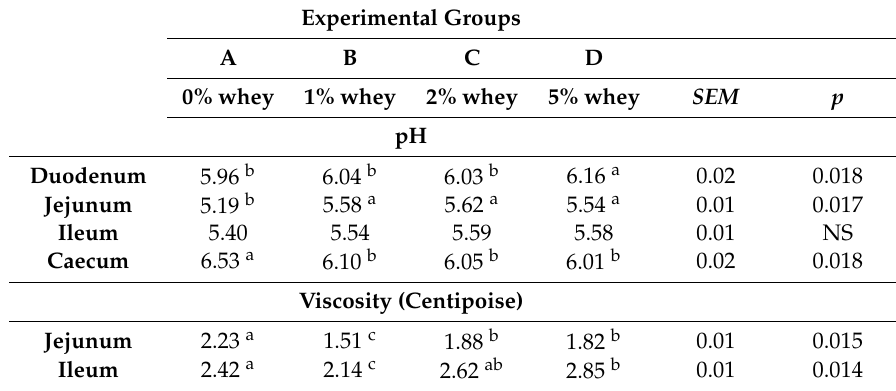
Table 4. E ff ect of whey in various concentrations in poultry diets on the pH and viscosity of intestinal digesta of broiler